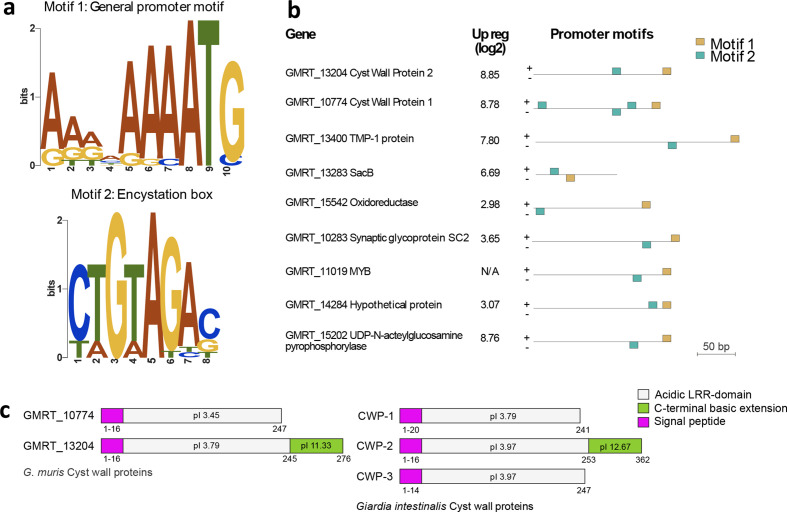
Gene regulation and organization of VSPs in G. muris. (a) Promoter motifs shared by encystation-related genes. Motif 1 [gold in (b)] represents the general promotor motif positioned directly adjacent to the start codon. Motif 2 [teal in (b)] resembles the encystation-regulated promoter previously identified in G. intestinalis (52). (b) The distribution and position of motif 1 (gold) and motif 2 (teal) in chosen genes regulated during encystation. (c) Giardia cyst wall proteins. Cyst wall protein 3 is missing in G. muris. Signal peptide (pink). Acidic LRR-domain (grey). C-terminal basic extension (green).